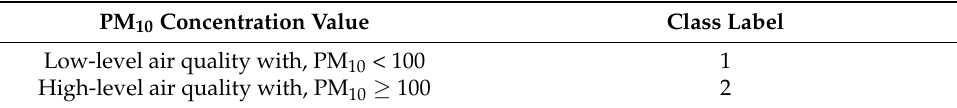
Table 1. Class labels for the next day’s PM 10